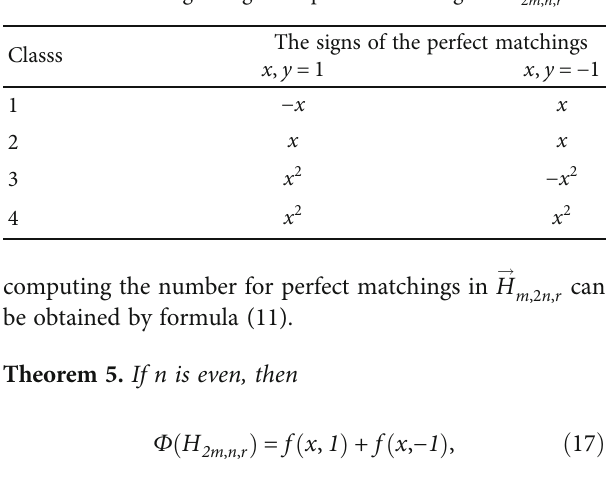
, where n is odd. 2 m , n , r